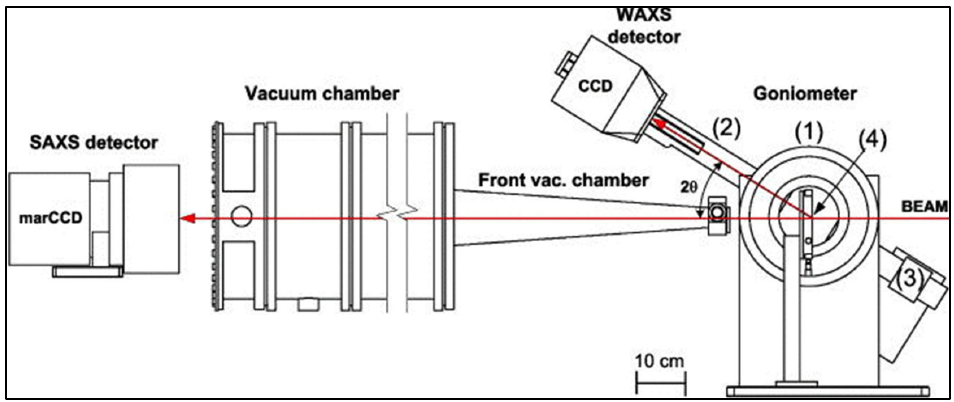
Figure 17. Small ‐ angle X ‐ ray scattering (SAXS)/wide ‐ angle X ‐ ray scattering (WAXS) Figure 17. Small-angle X-ray scattering (SAXS) / wide-angle X-ray scattering (WAXS) instrument for instrument for crystal and molecular analysis: (1) Rotation unit, (2) arm, (3) counterweight, crystal and molecular analysis: (1) Rotation unit, (2) arm, (3) counterweight, and (4) hot stage [79]. and (4) hot stage [79]. Table 5. SAXS / WAXS studies for characterization of polymeric